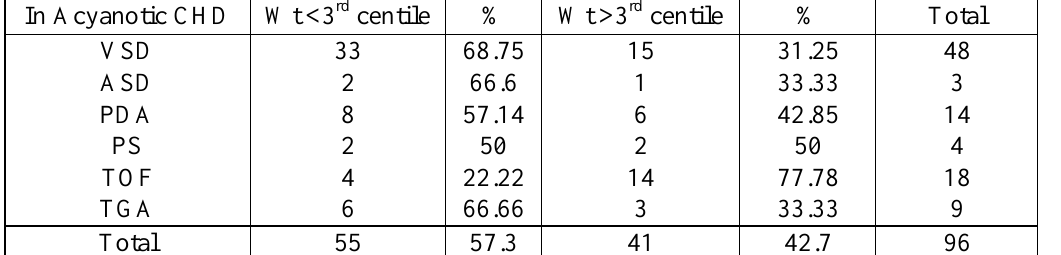
Table-3- the effects of CHD on growth pattern